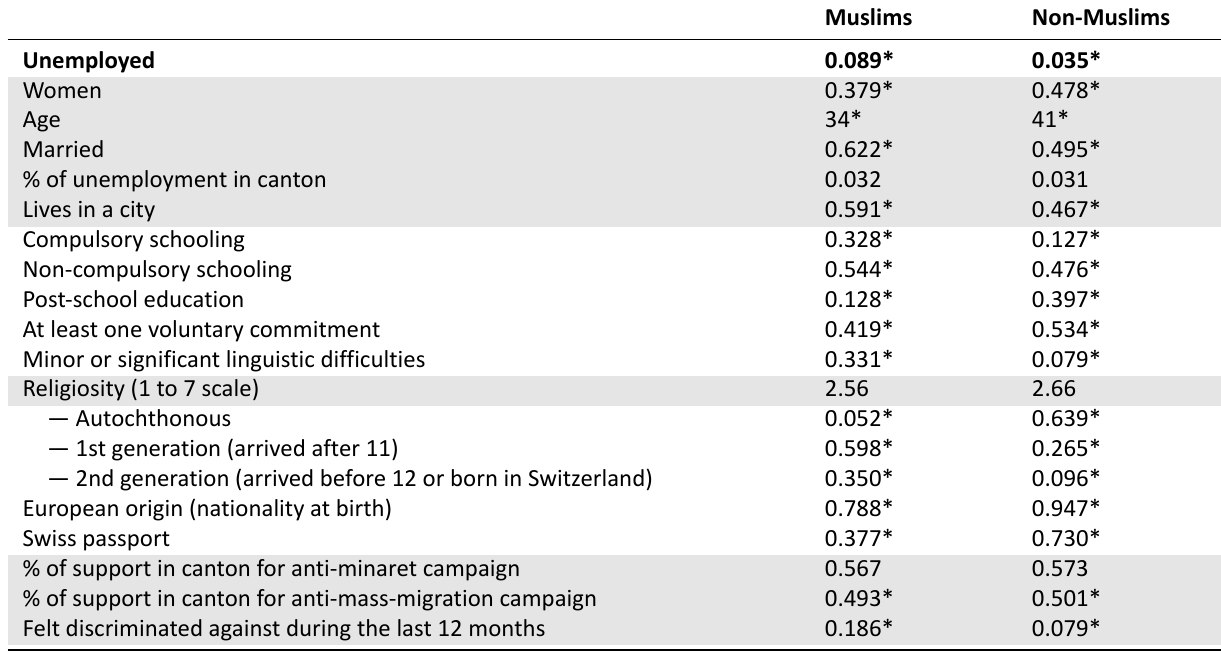
Table 1. Variable means and percentages by